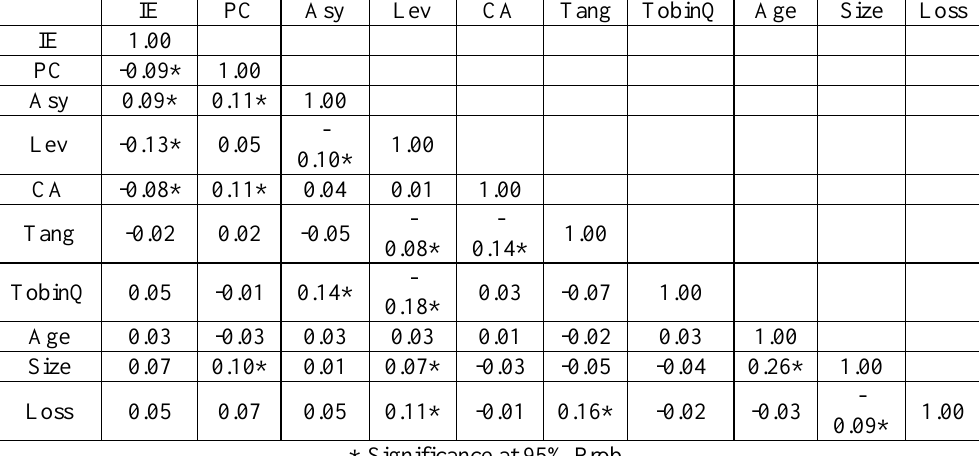
Table 4. Correlation between